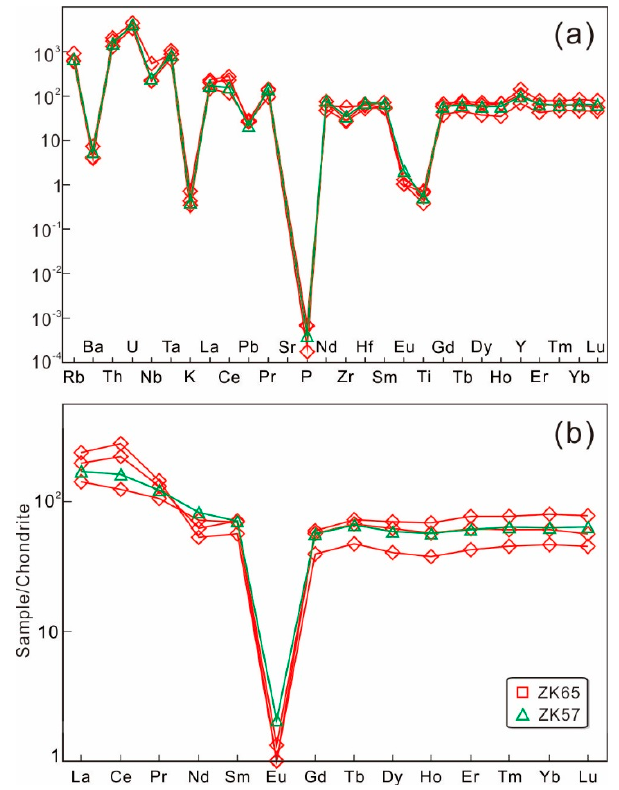
Figure 5. ( a ) Primitive mantle-normalized trace element spider diagram; ( b ) Chondrite-normalized REE patterns for the granites from the Xinfeng mine, Xianghualing area, South China. Normalized values for primitive mantle and chondrite are from Sun and McDonough [58].